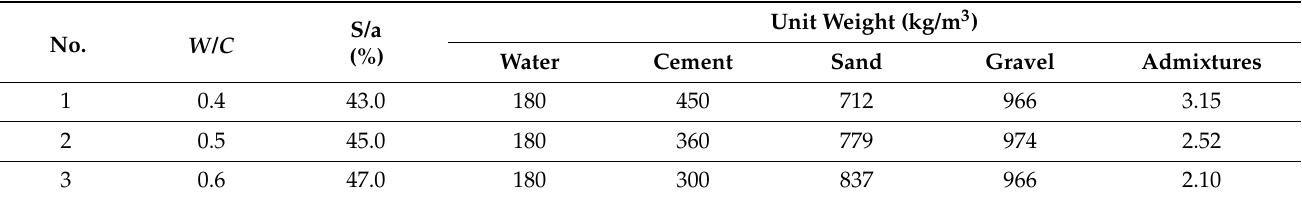
Table 1. Mix proportions for the test.